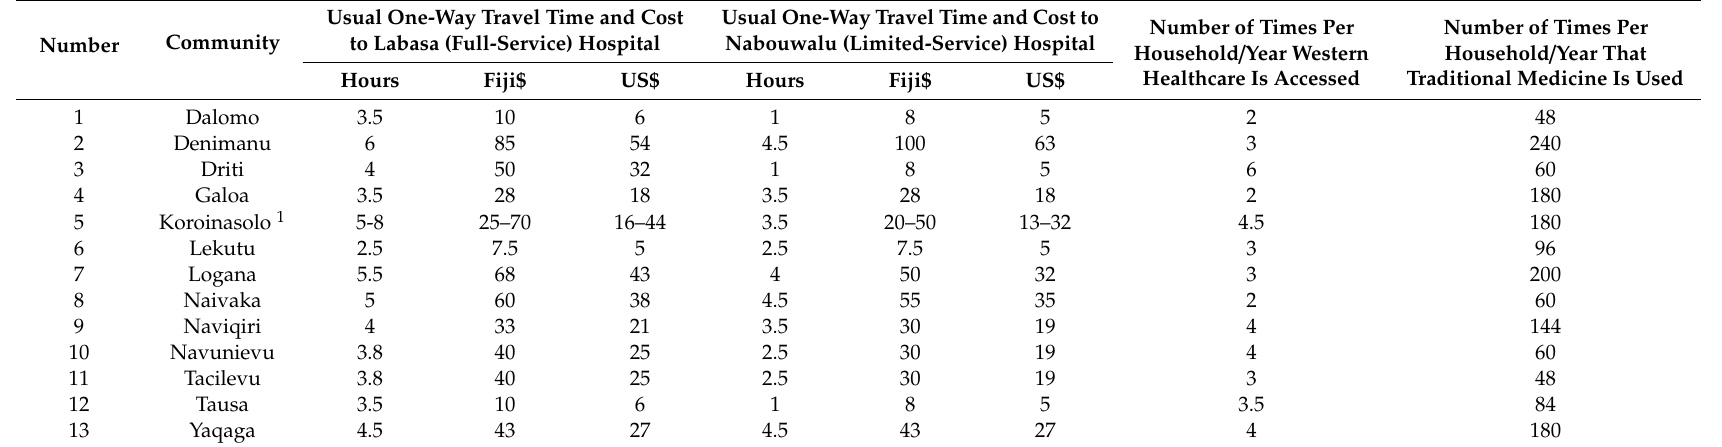
Table A2. Time and cost required to access western health solutions for the people of Bua, together with the number of times they had recourse to either western or traditional